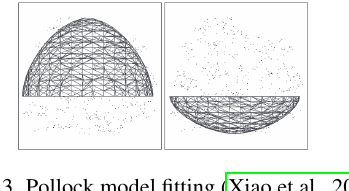
Figure 3. Pollock model fitting (Xiao et al., 2016)